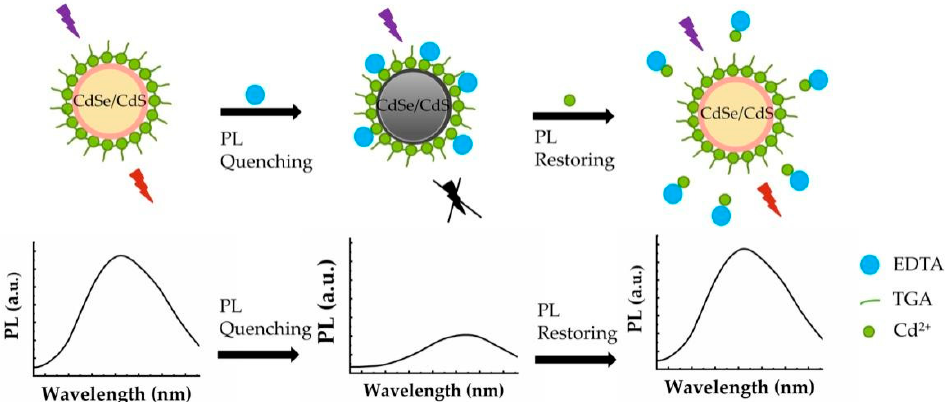
Figure 1. A schematic diagram of the detection of Cd 2+ in an aqueous solution by CdSe/CdS QDs based on OFF–ON mode through absorption and desorption processes.